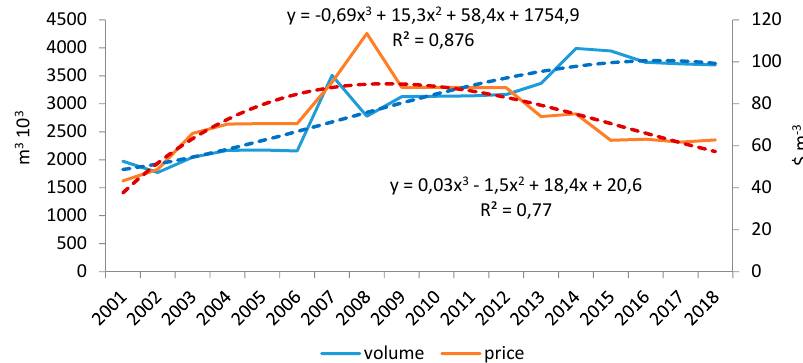
Figure 3. Volume (left axis) and prices (right axis) of beech roundwood imports in the years 2001– 2018.